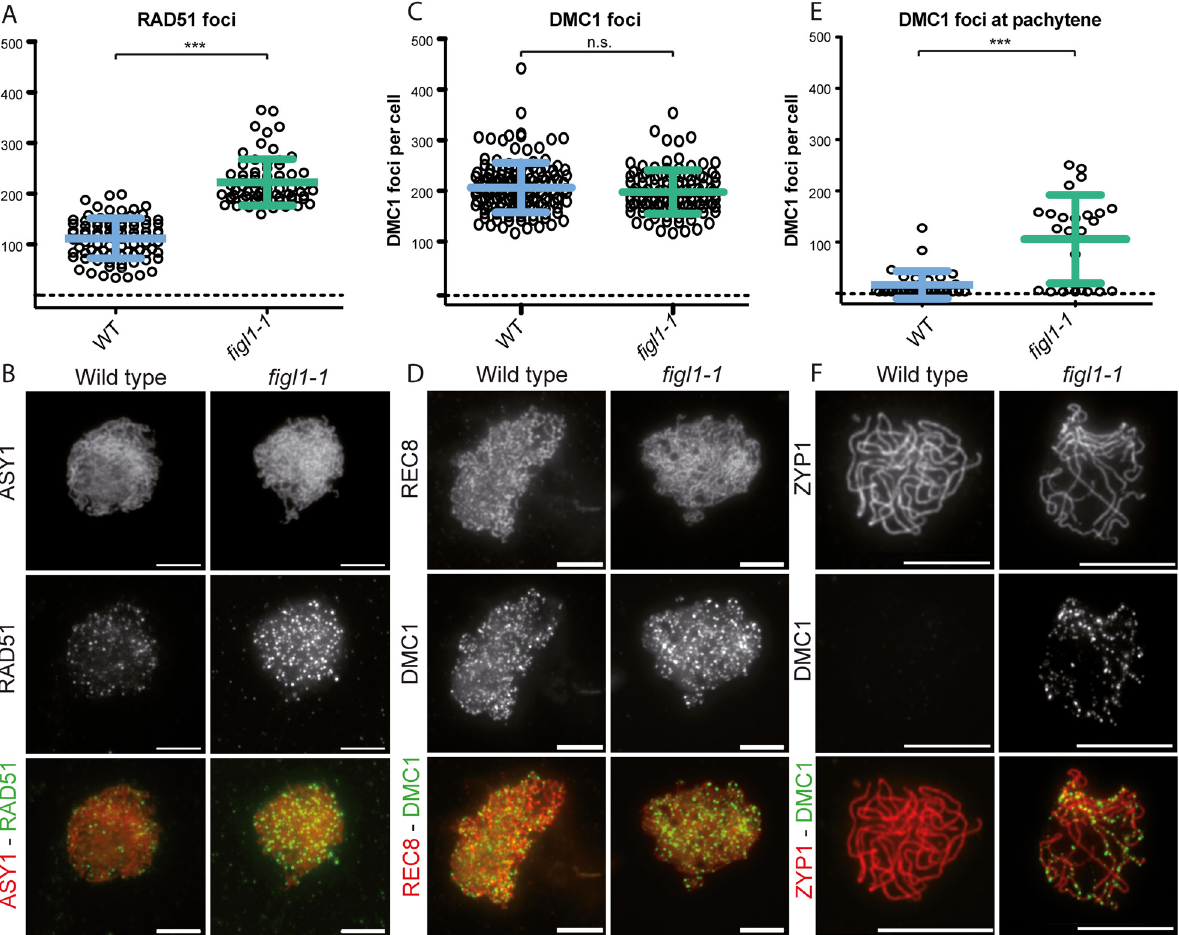
Fig 5. The dynamics of DMC1 and RAD51 are modified in figl1 . A and C: Number of RAD51 and DMC1 (respectively) foci count per positive cell throughout prophase in both wild type and figl1-1 mutant. n.s.: not significant; *** T-test p < 0,001. B: Illustration of RAD51immuno-localization at leptotene in wild type and figl1-1 mutant, with the axis protein ASY1used as a counterstain. D: Illustration of DMC1immuno-localization at leptotene in wild type and figl1-1 mutant, with the REC8 cohesin used as a counterstain. The same exposure and treatment parameters have been applied to all images of both wild type and figl1-1 . E: DMC1 foci count in pachytene cells ( *** T-test p < 0,001). ZYP1 staining was used as a marker for full synapsis, indicative of the pachytene stage. F: Illustration of DMC1 immuno-localization at pachytene, with ZYP1 as a counterstain.